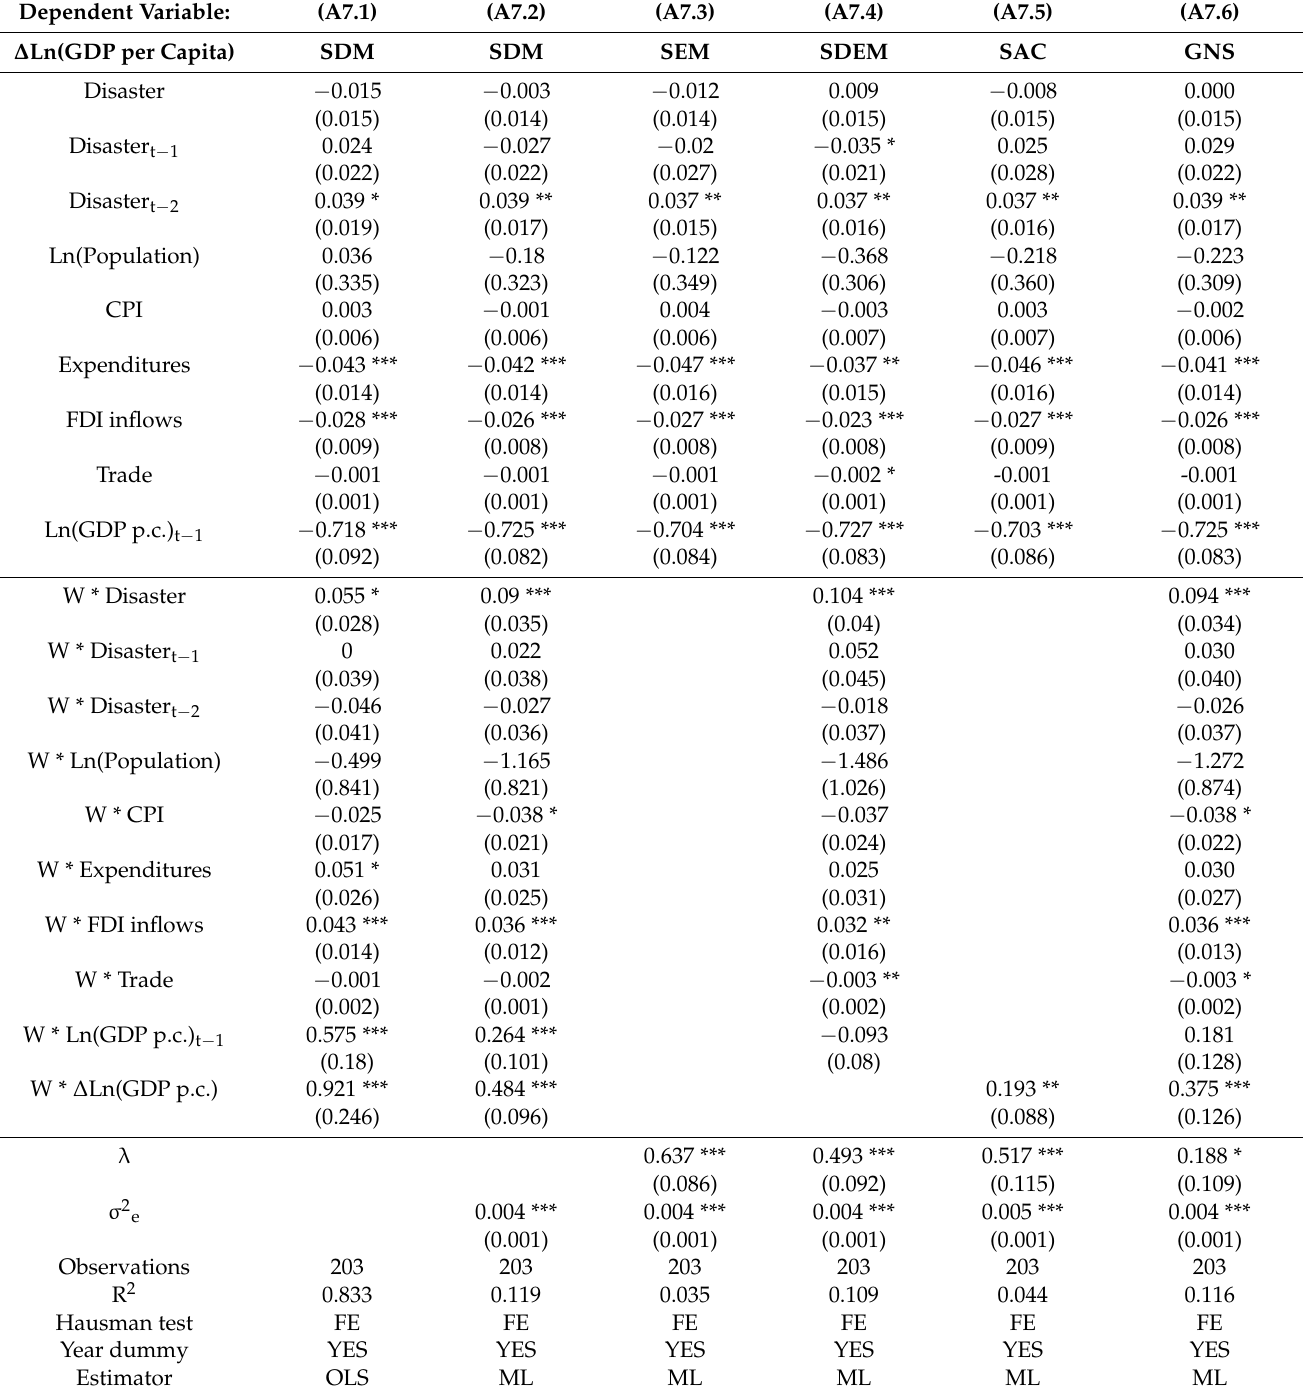
Table A7. Comparison of different spatial panel models (SDM, SEM, SDEM, SAC, and